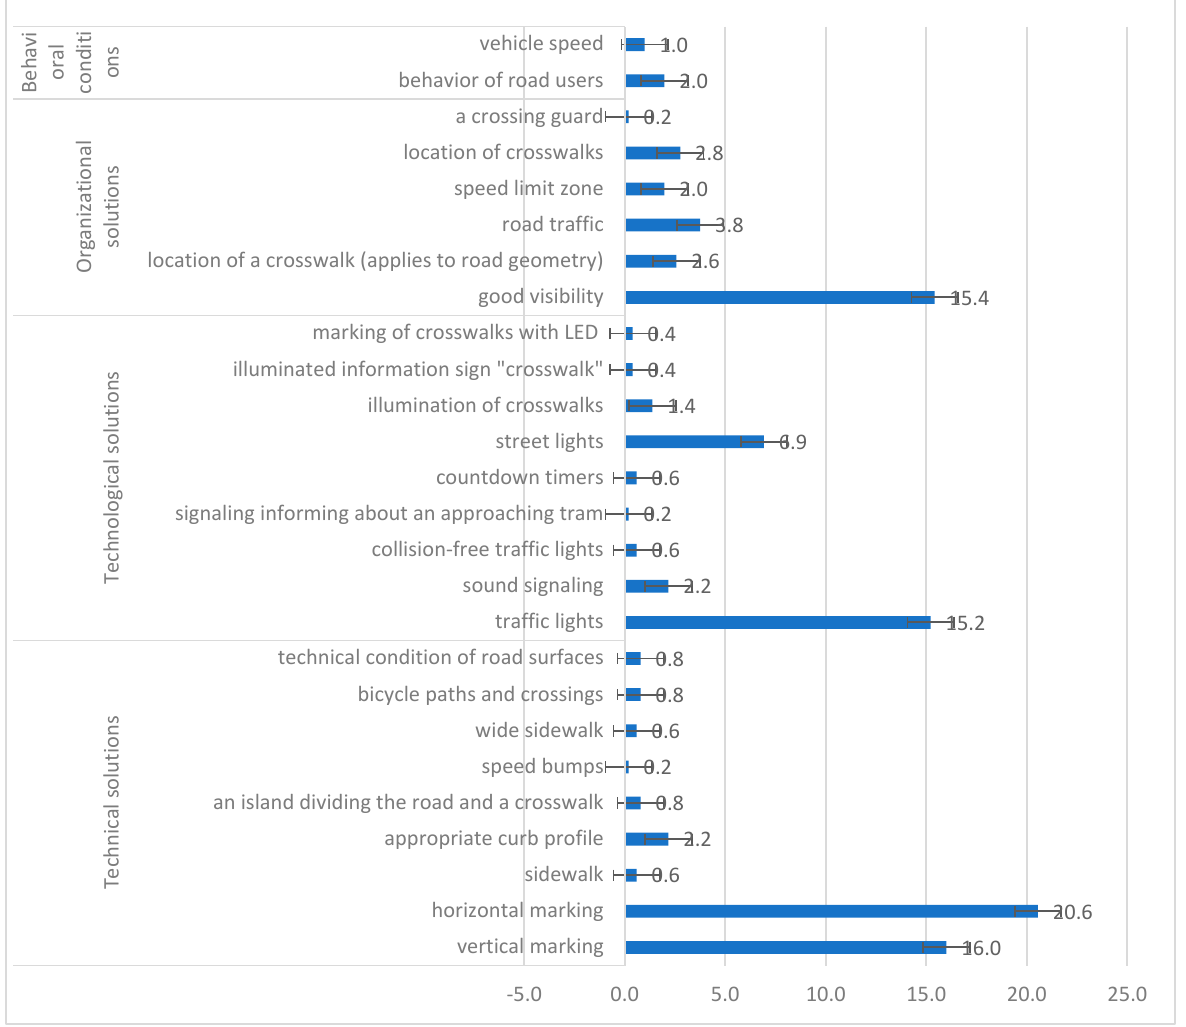
Figure 7. Factors influencing the safety of crosswalks.